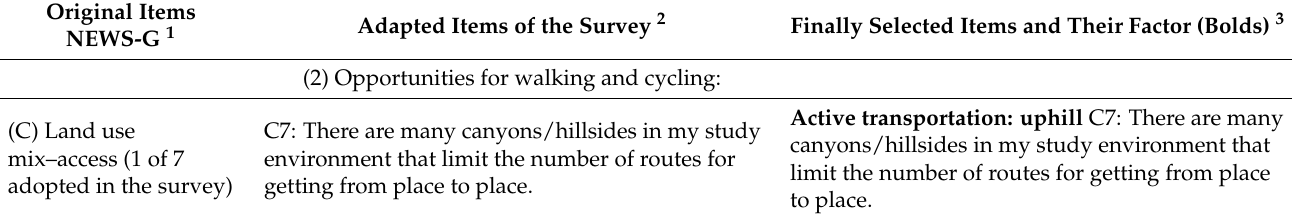
Table A1. Comparison of the finally selected items and their category bundled by the factor analysis and content fit in this article with the adapted categories of the NEWS-G 1 [44] for the study environment asked in the survey. Original